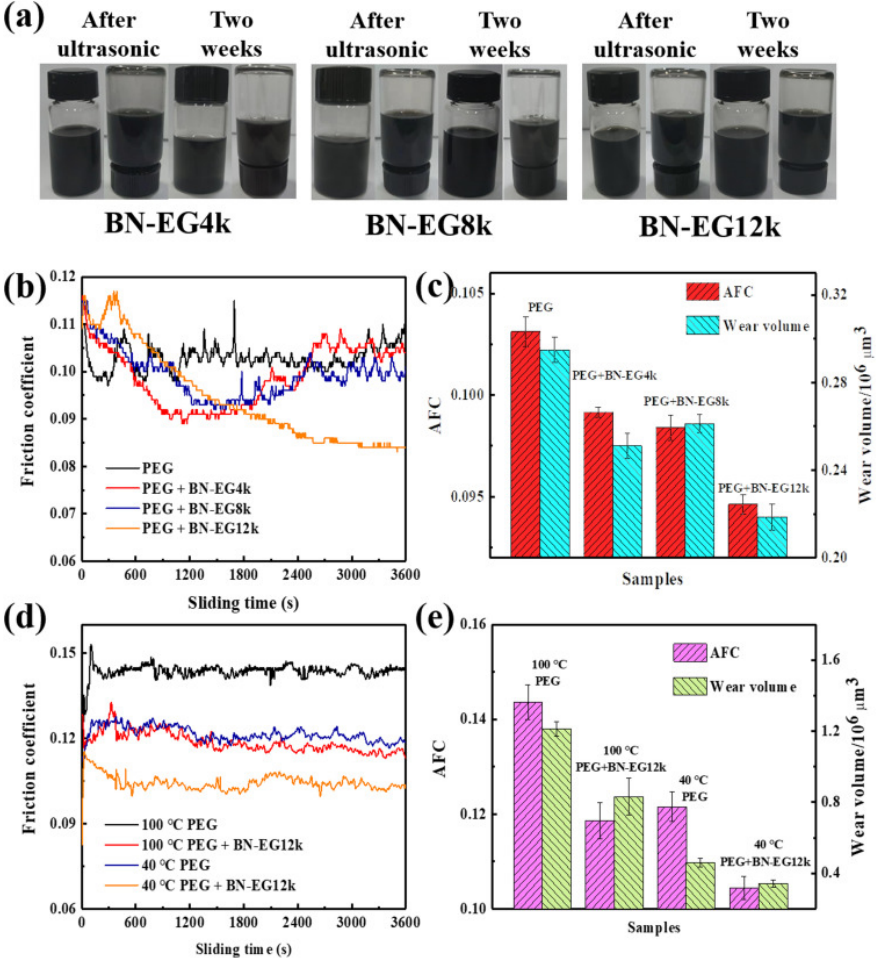
Fig. 11 (a) Images of BN-EG4k, BN-EG8k, and BN-EG12k dispersing in PEG200 and comparison after two weeks. (b) Curve of their friction coefficient with sliding time at RT; (c) histograms of average friction coefficient (AFC) and wear volume. (d) Curve of their friction coefficient of the BN-EG12k-containing lubricant and pure PEG200 at temperature of 40 and 100 °C; (e) histograms of AFC and wear volume [161]. Reproduced with permission from Ref. [161], © Elsevier Ltd.,